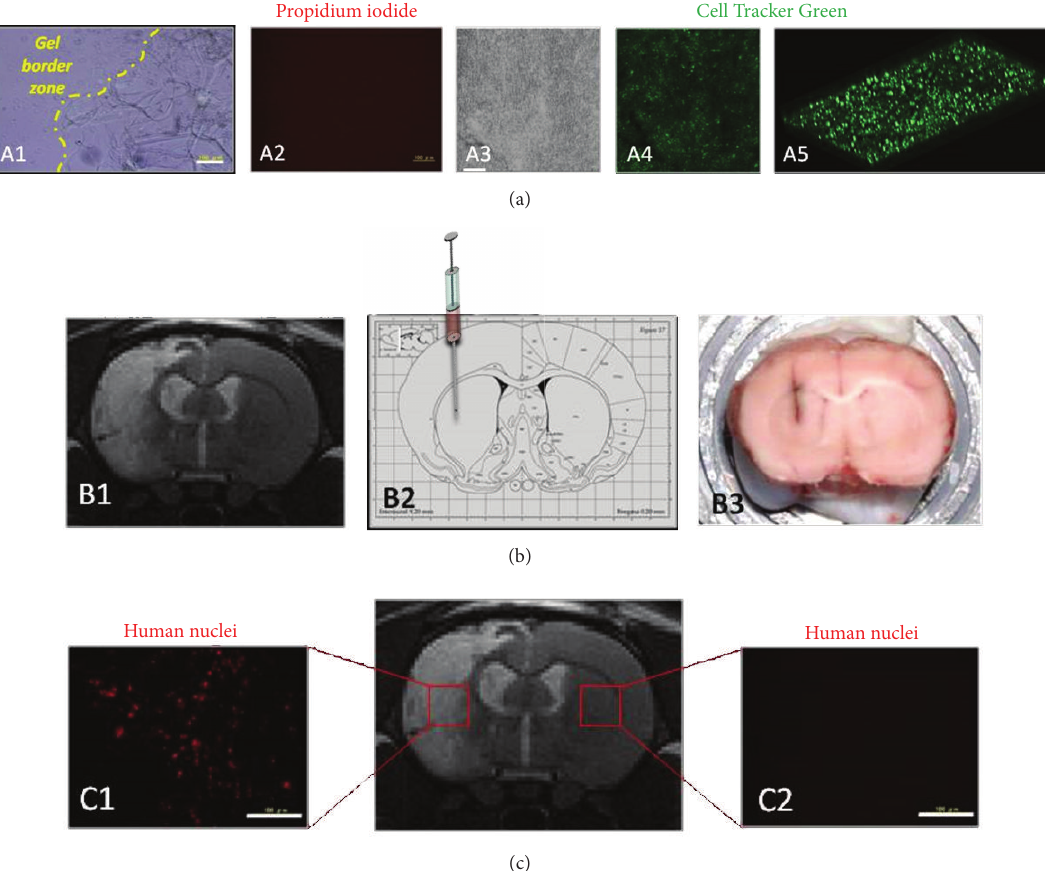
Figure 2: Different experimental steps for intracerebral graft of cell-biomaterial after stroke. Scale bar = 100 𝜇 m. (a) In vitro biocompatibility: after mixing human mesenchymal stem cells (MSC) within hyaluronic acid (HA) hydrogel (Hystem HP, Sigma: hyaluronan+polyethylene glycol diacrylate), MSC survived into the gel during several days in culture (A1) without cell death (A2, propidium iodide cell dead assay). Cell survival and spreading into the HA gel were assessed in one-week culture (A3) using confocal microscopy and confocal microscopy stacks and viable cell labelling (A4 and A5, Cell Tracker Green CMFDA, Life). (b) Intracerebral transplantation: one week after experimental ischemic stroke in rat, magnetic resonance imaging was used to determine the injection site into the stroke cavity near plastic areas surrounding the lesion (B1). Coordinates for stereotactic injection were defined using anatomic atlas (Watson-Paxinos) (B2). By histology, the stereotactic tract can bemacroscopically observed (B3, crysostat section). (c) In vivo biocompatibility and effects: ex vivo brain immunohistology demonstrated cell survival into the graft site such as human MSC identification in stroke lesion (C1, human-specific monoclonal antibody to nuclear antigen, MAB1281, 1/1,000, Chemicon) without cell migration in contralateral hemisphere (C2). Additional experiments must be done to assess long- term cell differentiations and host integration, hydrogel biodegradation, local inflammatory response, and behavior recovery